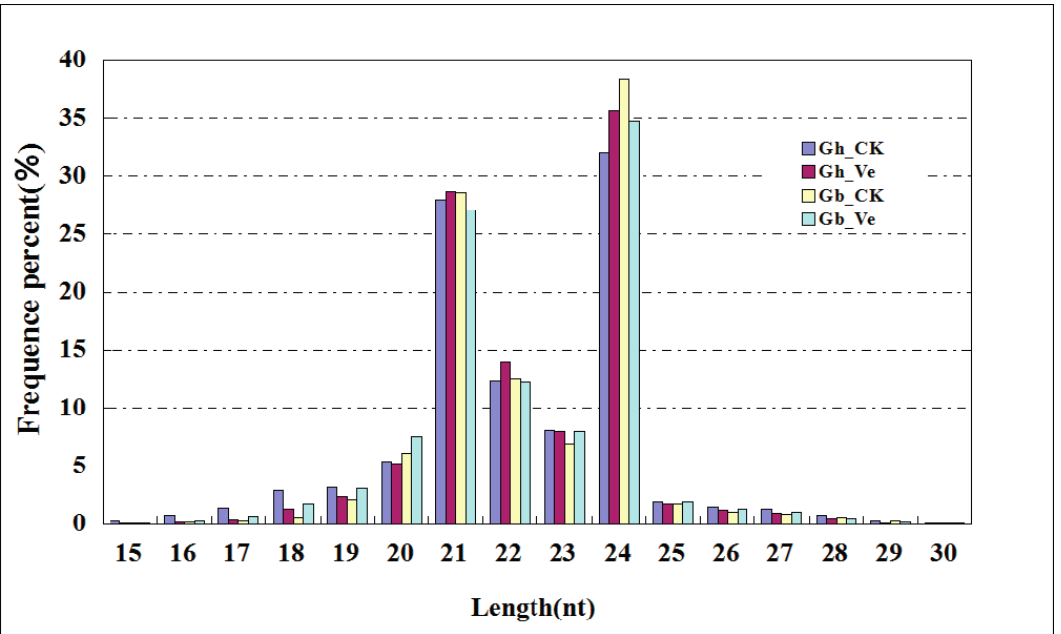
Figure 1. Length distribution of sRNAs in G. hirsutum roots and G. barbadense